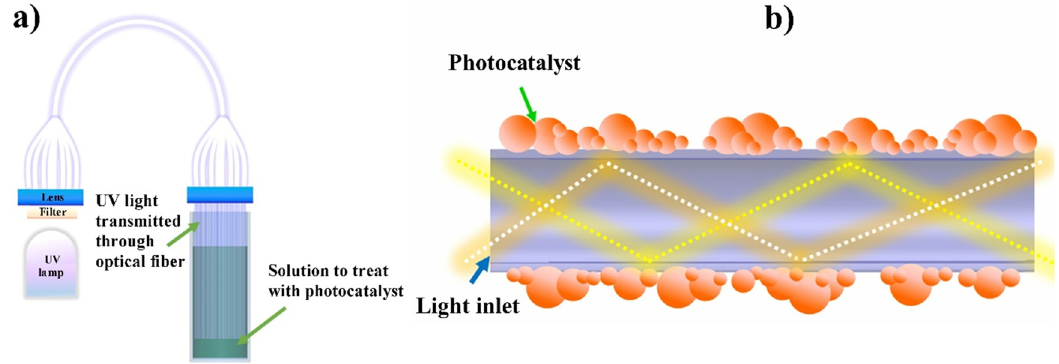
Figure 9: ( a ) Reactor fed by a concentration system of natural or arti fi cial source, transporting the lighting via optical fi ber, for the treatment having the optical fi ber within the solution to be treated and the photocatalyst in suspension. ( b ) Representation of a fi ber optic system with a photocatalyst